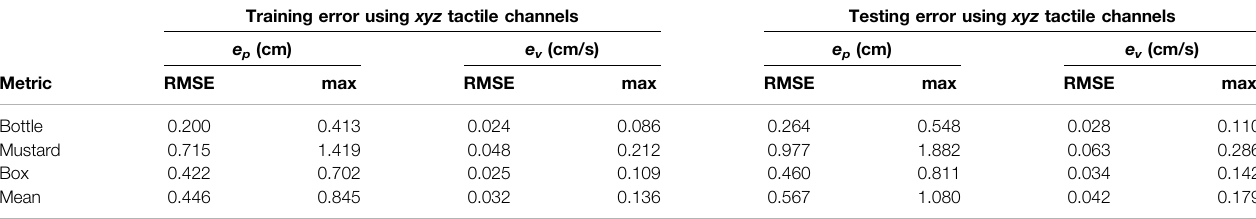
TABLE 1 | Position and velocity RMS and maximum training and testing errors using the full ( xyz ) set of the tactile channels for all the fi ngers. Training error using xyz tactile